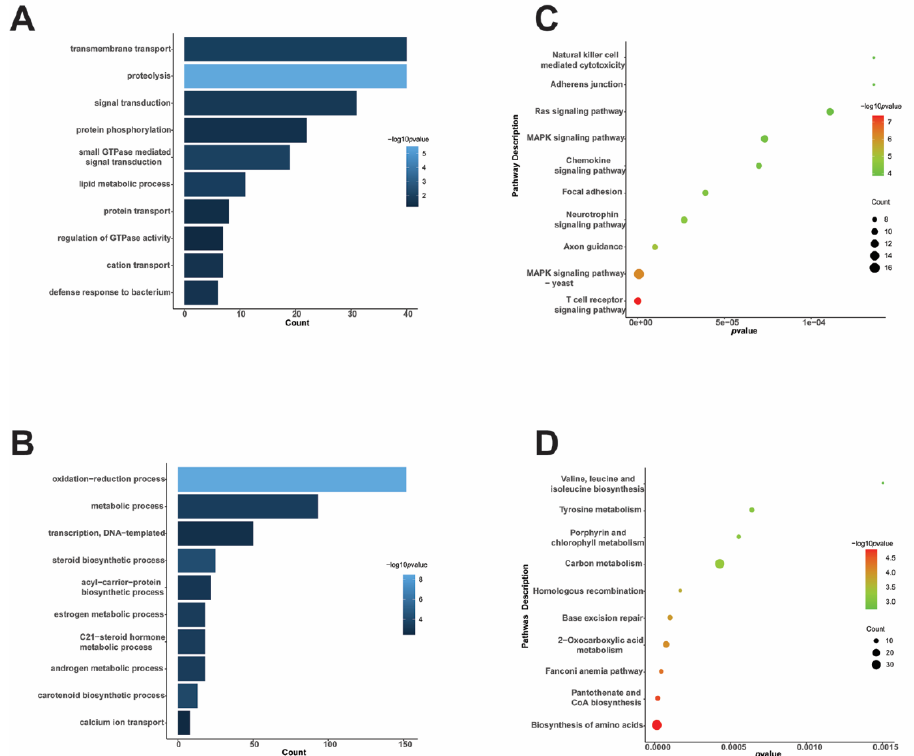
Figure 2. Visualization of top ten gene ontology (GO) terms of biological processes (BP) and Kyoto encyclopedia of genes and genomes (KEGG) enriched pathways. ( A ) GO terms of upregulated proteins and ( B ) GO terms of downregulated proteins in DM: the –log10 ( q -value) color scale is shown on the right. ( C , D ) KEGG enriched pathways of upregulated proteins and downregulated proteins in DM, respectively: the q -value color scale and size scale of protein counts are shown on the